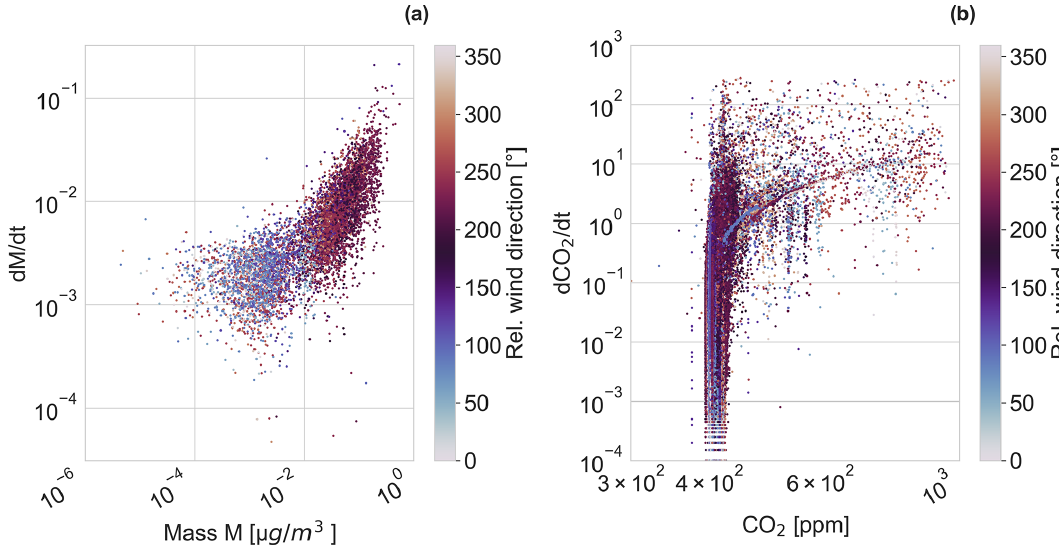
Figure 10. (a) Derivative of the ion mass signal of C 4 H + ( m/z = 57) compared to its total mass concentration, measured by the AMS. 9 (b) Derivative of the CO 2 concentration signal compared to its concentration, measured by cavity ring-down spectroscopy. Colors indicate the relative wind